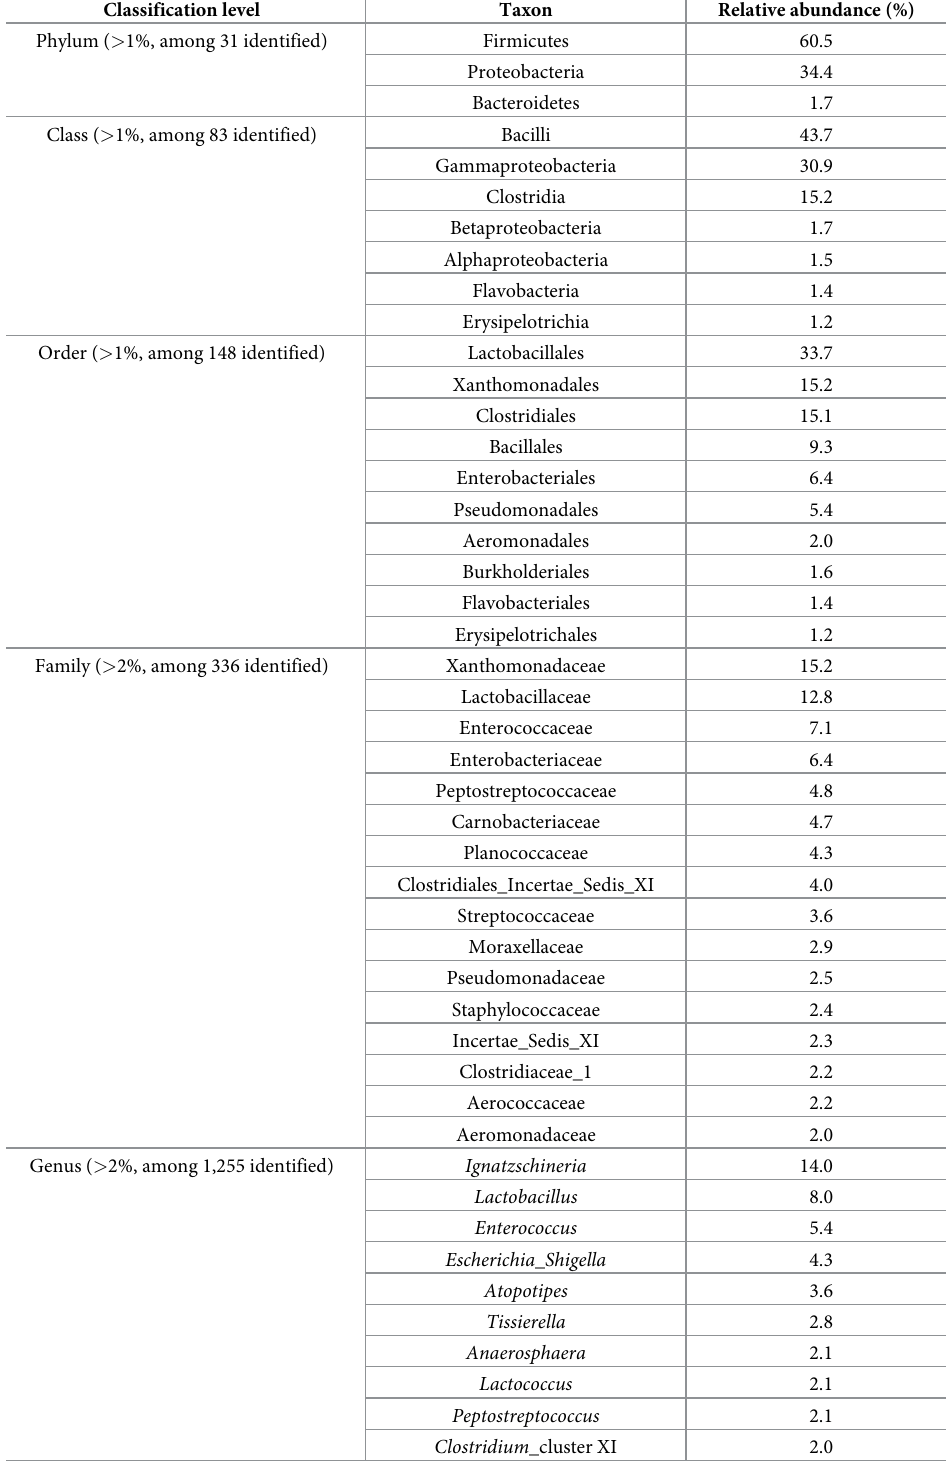
Table 3. Median relative abundance of predominant taxonomic classifications of bacteria from the feces of com- mercial mink (n = 366). Samples were obtained from 49 farms in the summers of 2014 and 2015 and winter